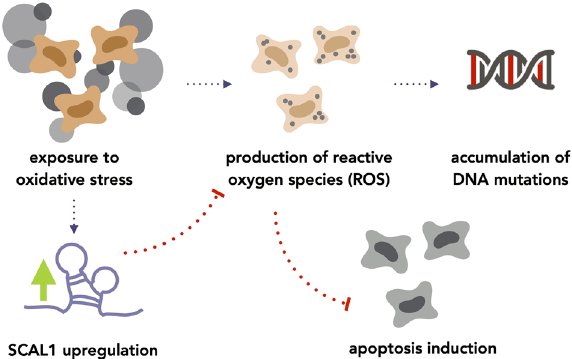
Figure 6. Postulated pathway of SCAL1 upregulation to account for ROS reduction upon CSE exposure. SCAL1 may be upregulated in response to oxidative stress to inhibit ROS production, which may effectively inhibit the induction of